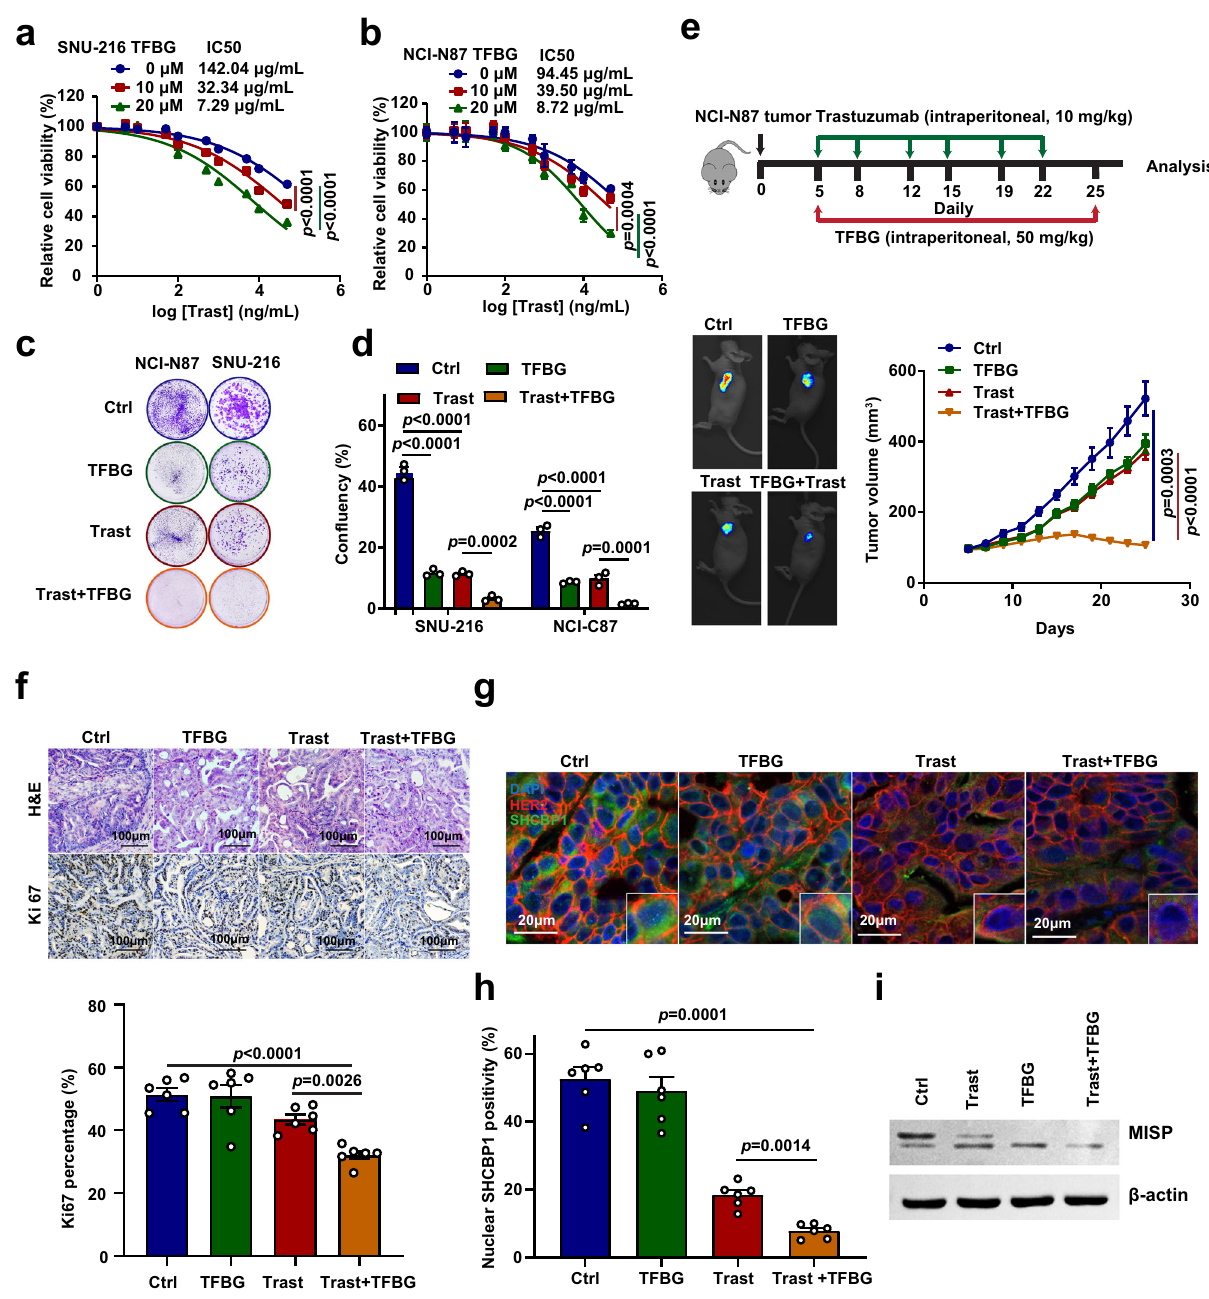
Fig. 7 Trastuzumab – TFBG combination is ef fi cient in treatment of HER2-positive gastric cancer. a , b Sensitivity to trastuzumab (Trast) in SNU-216 ( a ) and NCI-N87 ( b ) cells treated with thea fl avine-3, 3 ′ -digallate (TFBG) at the indicated concentrations. Cell proliferation was analyzed after 6 days of treatment. Data are the mean ± s.e.m. The p values were determined by one-way ANOVA ( n = 6 independent biological samples). c , d Colony formation ( c ) and the statistical results ( d ) of NCI-N87 and SNU-216 cells in the continuous presence of trastuzumab (10 μ g/mL) and/or TFBG (10 μ M). Data are the mean ± s.e.m. The p values were determined by one-way ANOVA ( n = 3 independent biological samples). e Representative image and tumor growth curves of xenograft mice carrying NCI-N87 cell tumors treated with trastuzumab (intraperitoneal, 10 mg/kg, 2×/wk× 3), TFBG (intraperitoneal, 50 mg/kg, 1×/day × 21), or a combination of the agents. The detailed strategy of drugs treatment is displayed ( e , top). Data are the mean ± s.e.m. The p values were determined by one-way ANOVA ( n = 8 independent mice per group). f Representative images of hematoxylin – eosin (H&E) and Ki-67 immunohistochemical analysis (top) and quanti fi cation of Ki-67-positive cells (bottom) in mice xenograft tumors treated with trastuzumab and/or TFBG. Data are the mean ± s.e.m. The p values were determined by one-way ANOVA ( n = 6 independent biological samples). g , h Immuno fl uorescence staining and the statistical results of SHCBP1 nuclear localization in mice xenograft tumors. Tissues were co-stained with anti-SHCBP1 antibody (green), anti-ERBB2 antibody (red), and DAPI (blue). The positivity of SHCBP1 in the nucleus was quanti fi ed using Image J V1.53c software. Data are the mean ± s.e.m. The p values were determined by one-way ANOVA ( n = 6 independent biological samples). i Detection of MISP phosphorylation in mice xenograft tumors by immunoblotting. Data of i are representative of two independent